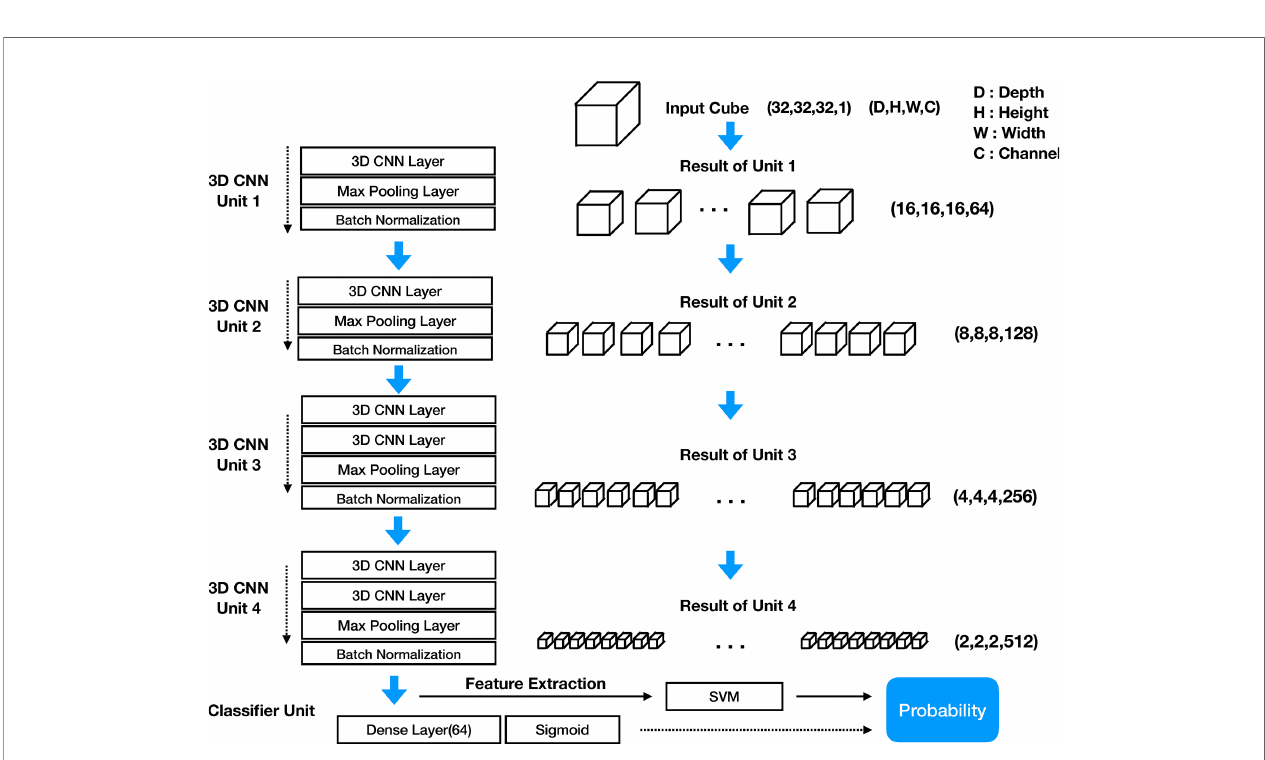
FIGURE 4 | Architecture of DeepCUBIT model.